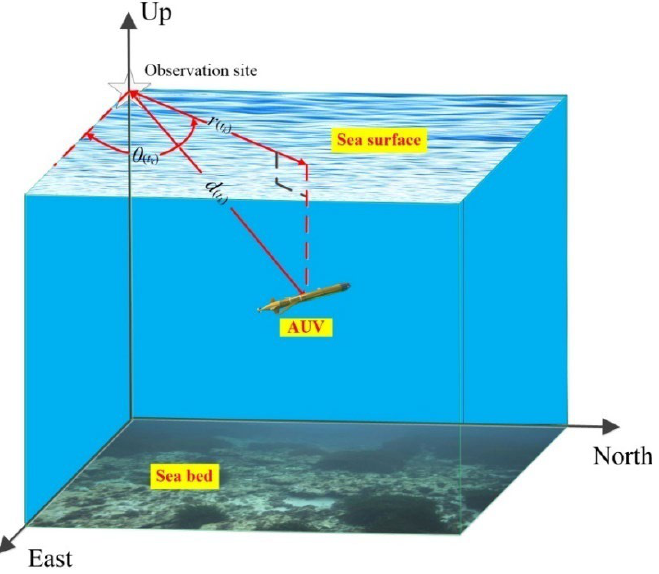
Figure 1. The motion model of the AUV and underwater navigation. Case 1: The measurement function is linear, including Case 1.1 , Case 1.2 , and Case 1.3